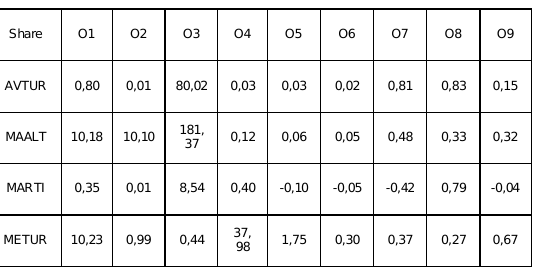
Table 7: Annual Standard Decision Matrix for the 2013- 2016 Period